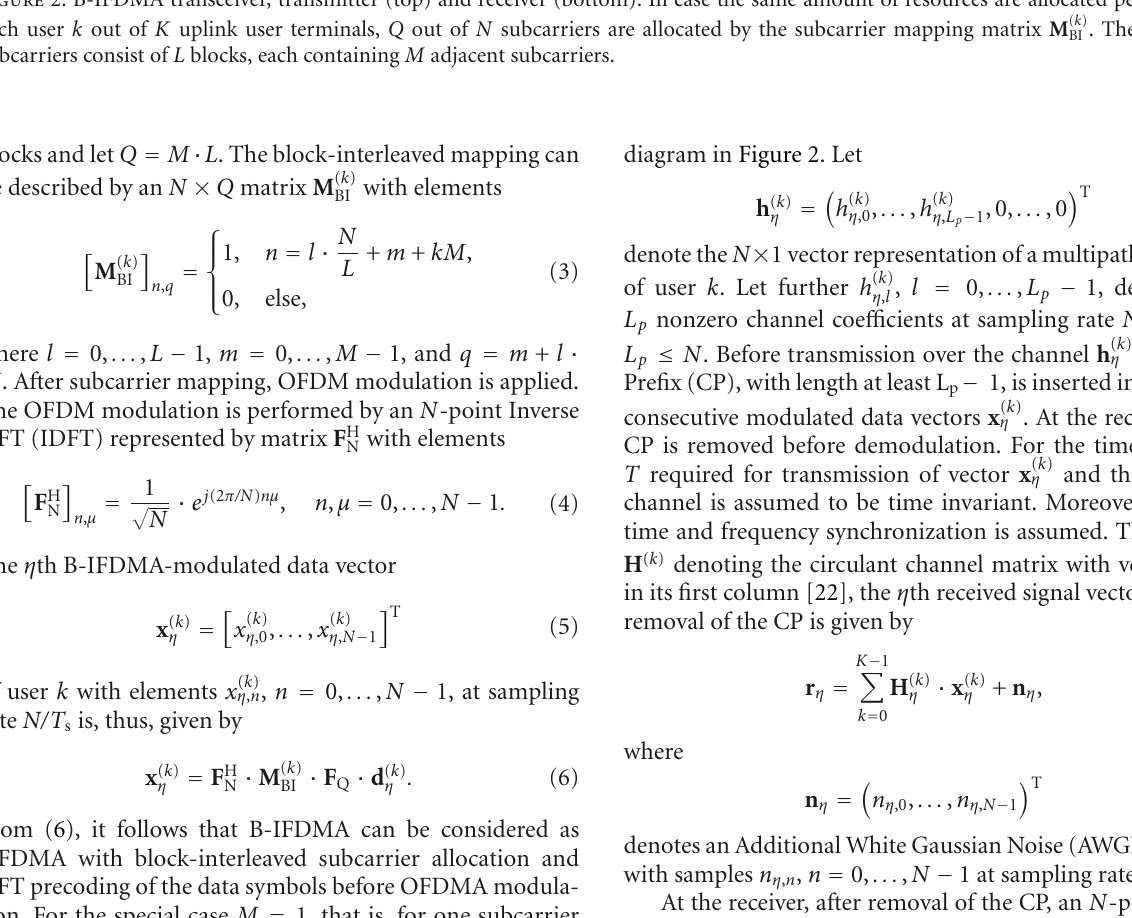
. The allocated BI